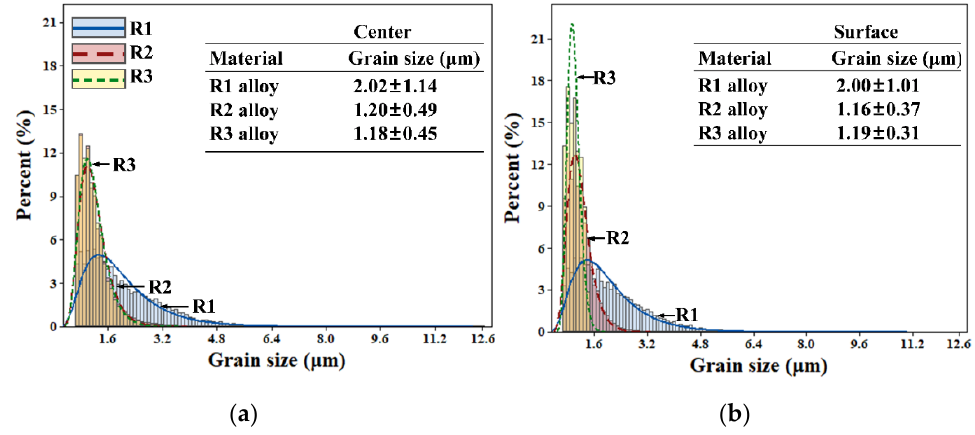
Figure 3. Average grain size and size distribution of R1, R2 and R3 alloy at the ( a ) center and ( b ) surface on the longitudinal section.